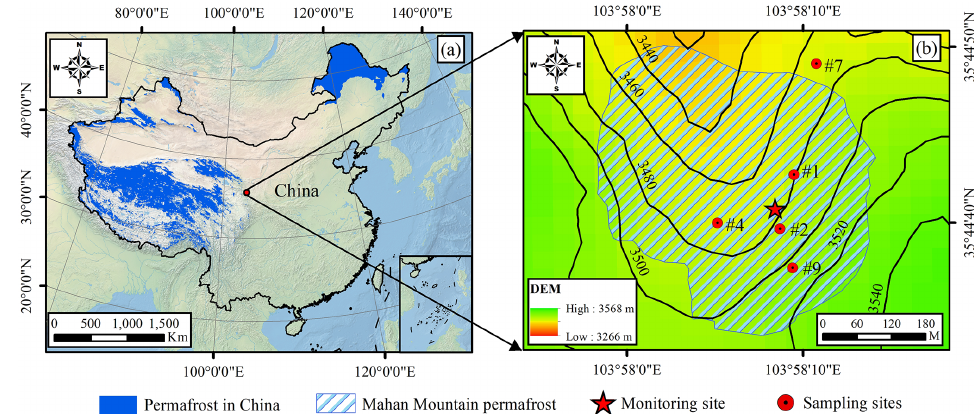
Figure 1. The location of Mahan Mountain relict permafrost region in China (a) and the spatial distribution of permafrost and monitoring sites in the study region (b) . Permafrost distribution data in China are derived from Zou et al. (2017) and Zhang et al. (2019), and the Environmental and Ecological Science Data Center for West China (http://www.ncdc.ac.cn/portal/metadata/d26f21f4-d17f-4523-865f-e0f3914034a5, last access: 17 March 2022). The permafrost distribution of the Mahan Mountain is derived from Xie et al. (2013). The high-resolution satellite- derived land cover data are provided by Natural Earth (http://www.naturalearthdata.com, last access: 17 March